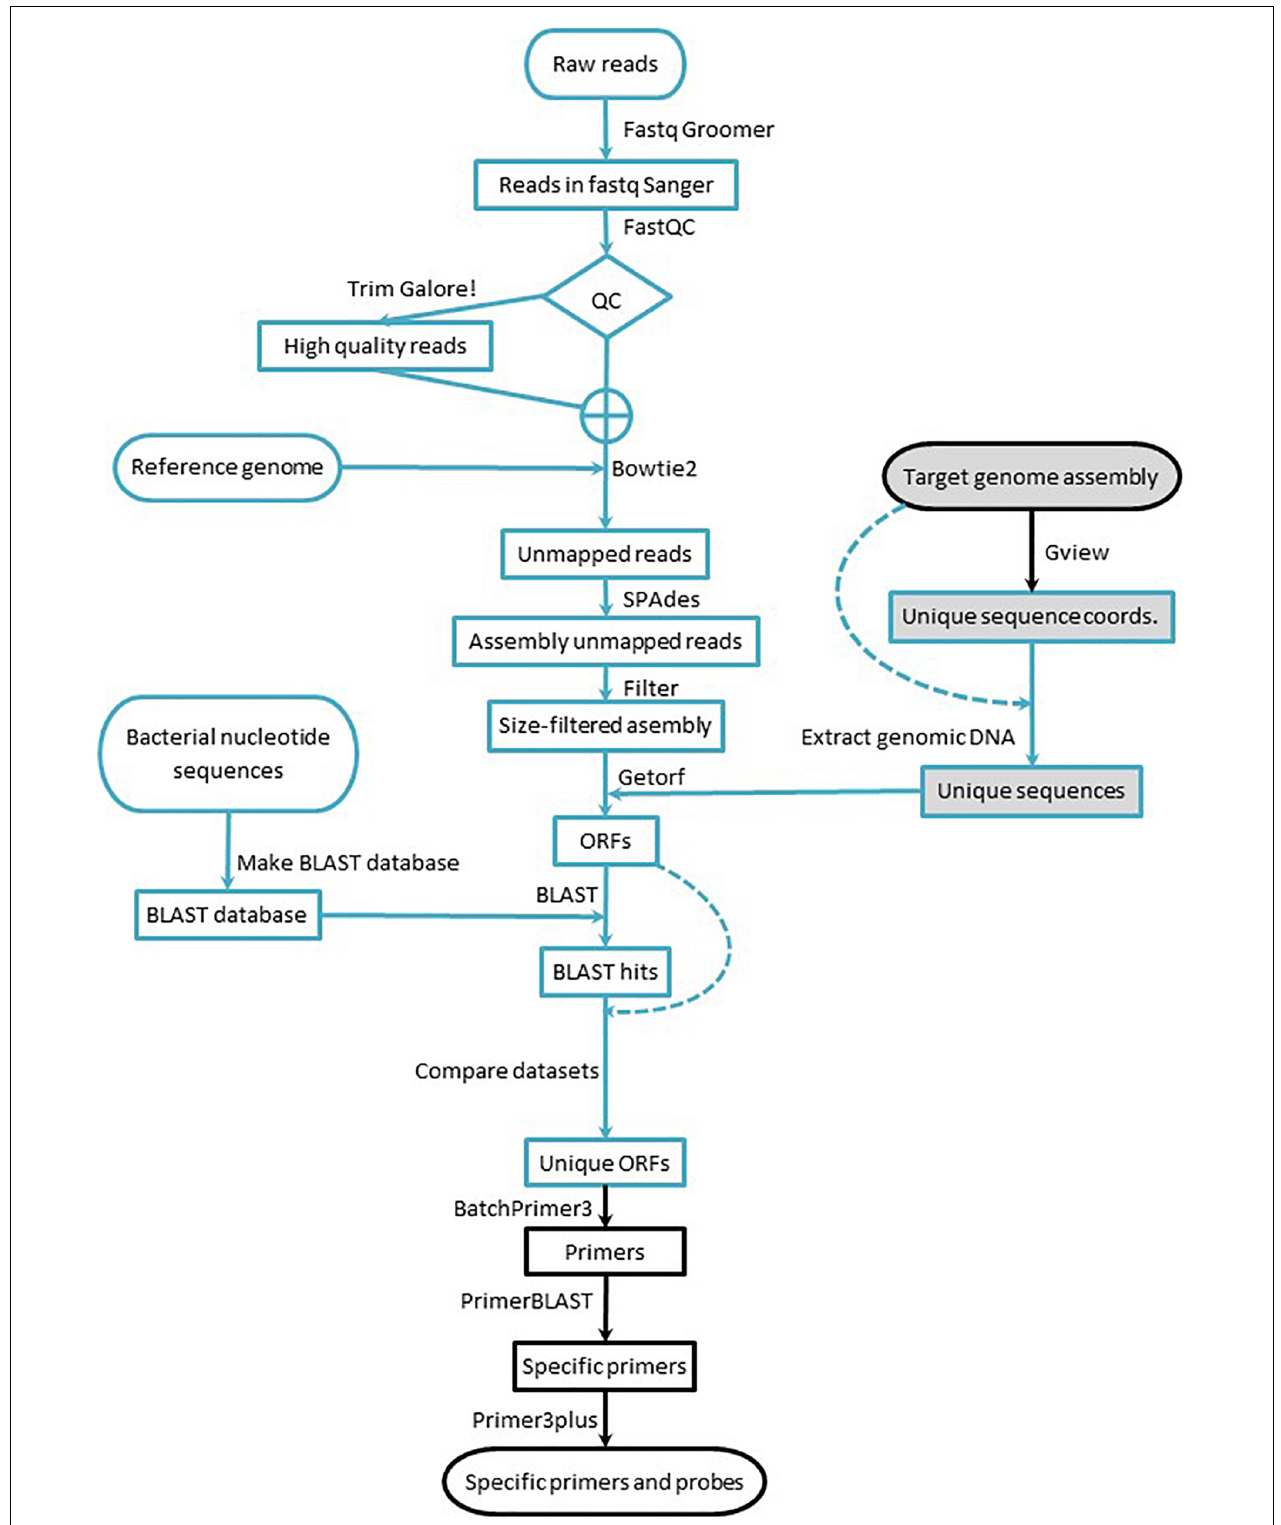
FIGURE 1 | Workflow for marker design. Blue lines indicate processes run in the Galaxy environment, and black lines indicate processes run using online tools. Arrows indicate the workflow direction, and dashed lines indicate processes that require a dataset for a second time. Shaded elements denote the part of the workflow applied to data acquired with long read sequencing